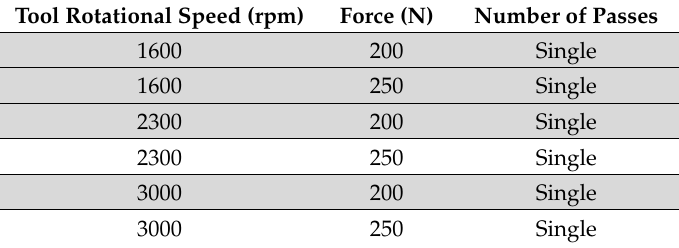
Table 4. Additional experiments to study the roughest surface.